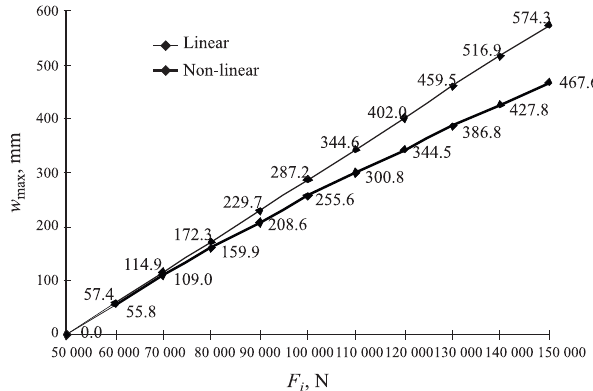
Fig. 6. Linear and non-linear relations between the nodal load F i and the max vertical deflection of the cable w max (based on the first simplification)